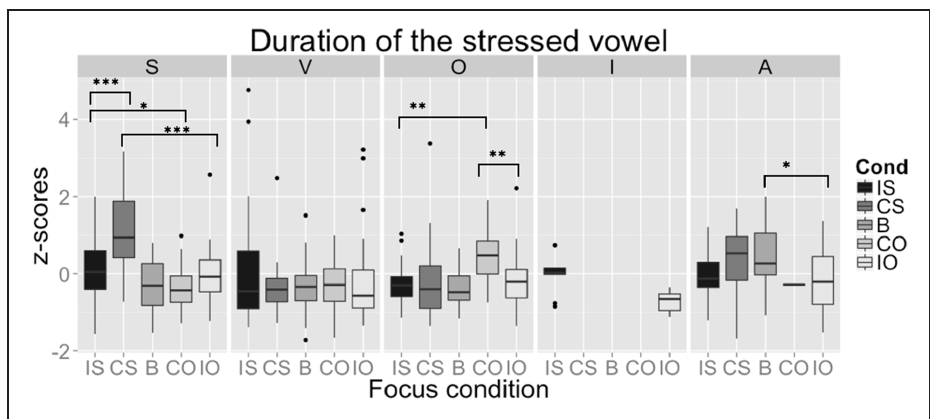
Figure 12: Duration of the stressed vowel in each content word (subjects, verbs, objects, indirect objects and adjuncts) in the following focus conditions: Informational focus (IS), contrastive focus (CS), broad focus (B) or non-focused in contexts of contrastive object focus (CO) and informational object focus